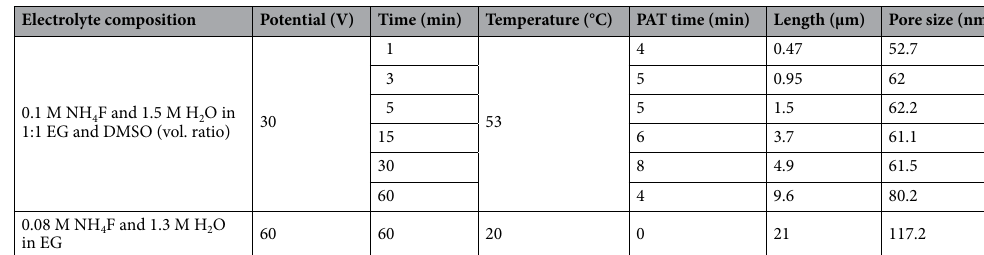
Table 2. Conditions of 2nd anodization process.